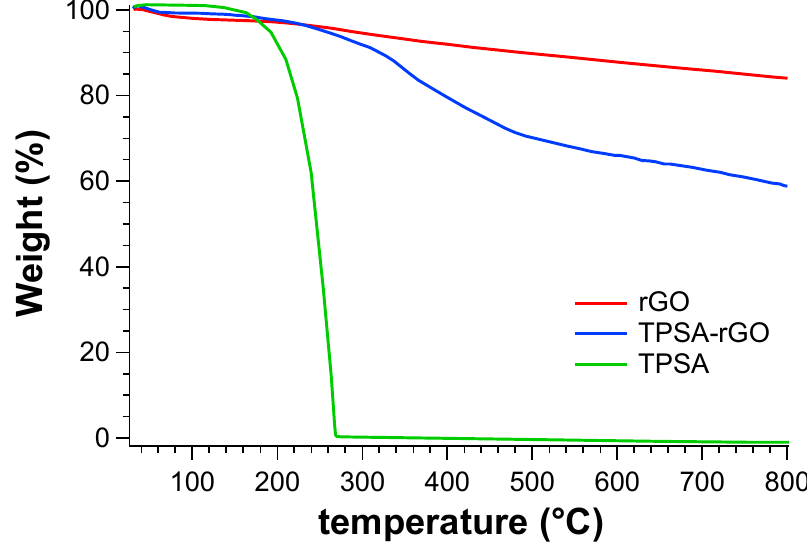
Figure 6. TGA analysis of TPSA, rGO, and TPSA-rGO.